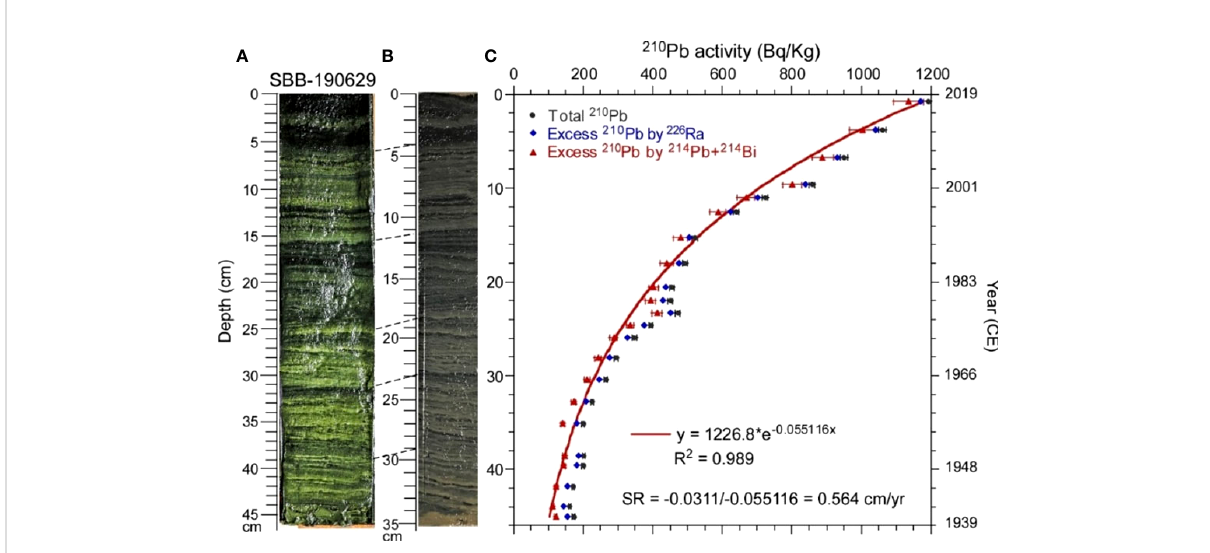
FIGURE 2 Photos and 210 Pb pro fi le of core SBB-190629. (A) Photo of the core before transportation to National Taiwan University (NTU). (B) Photo of the core after transportation to NTU. (C) 210 Pb pro fi le. The constructed ages are shown on the right-hand side of the plot. Red line represents the fi tting